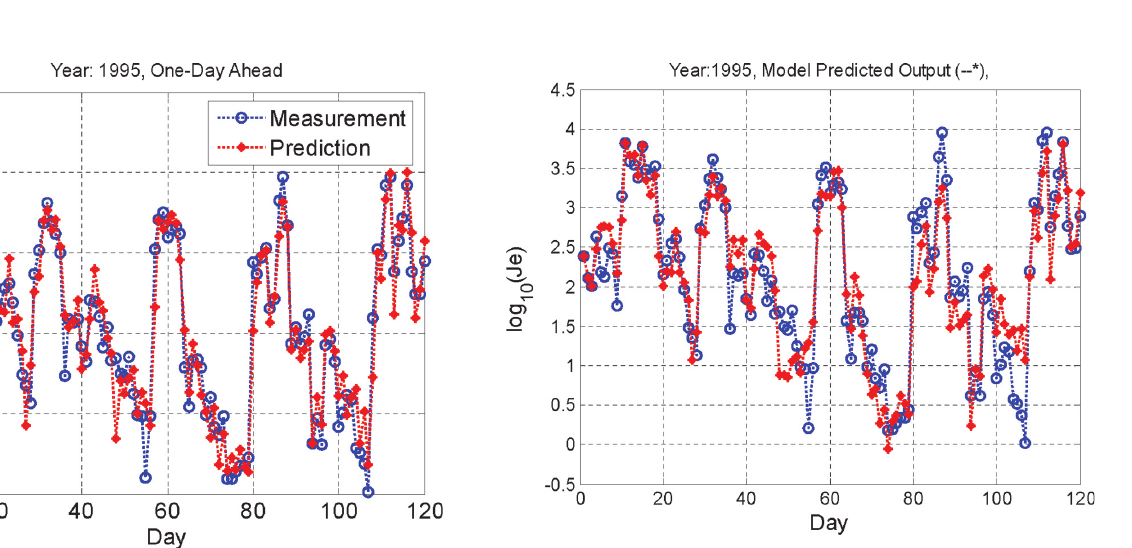
Fig. 2. A comparison between model predicted outputs and the corresponding measurements during a period in year 1995. Note that the model was generated from the initial full model with time lags up to m =